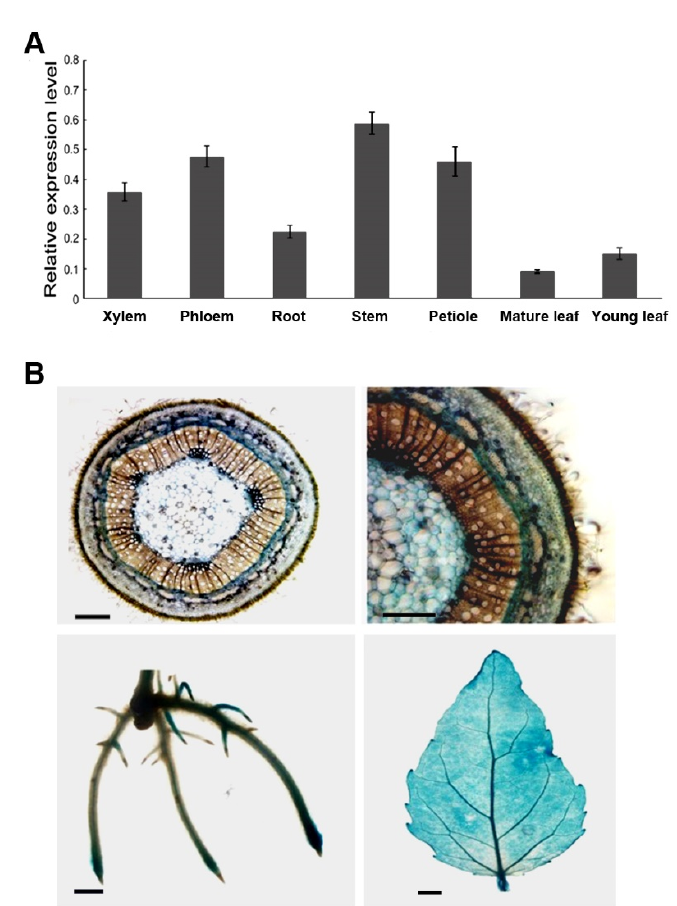
Figure 2. Expression patterns of PtoMYB055 in poplar. ( A ) Real-time quantitative PCR analysis of PtoMYB055 transcript levels in various tissues of Populus tomentosa Carr. Expression of the 18S gene was used as a control. Error bars represent ± SD of three biological replicates. ( B ) Promoter analyses of PtrMYB055 with GUS ( β -glucuronidase) staining in various tissues of mature PtoMYB055 :GUS plants. Upper plane, stem, scale bar = 500 µ m; lower left plane: root, scale bar = 5 mm; lower right plane: leaf, scale bar = 2 mm.